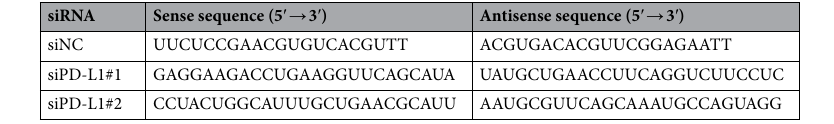
Table 1. siRNA sequences of